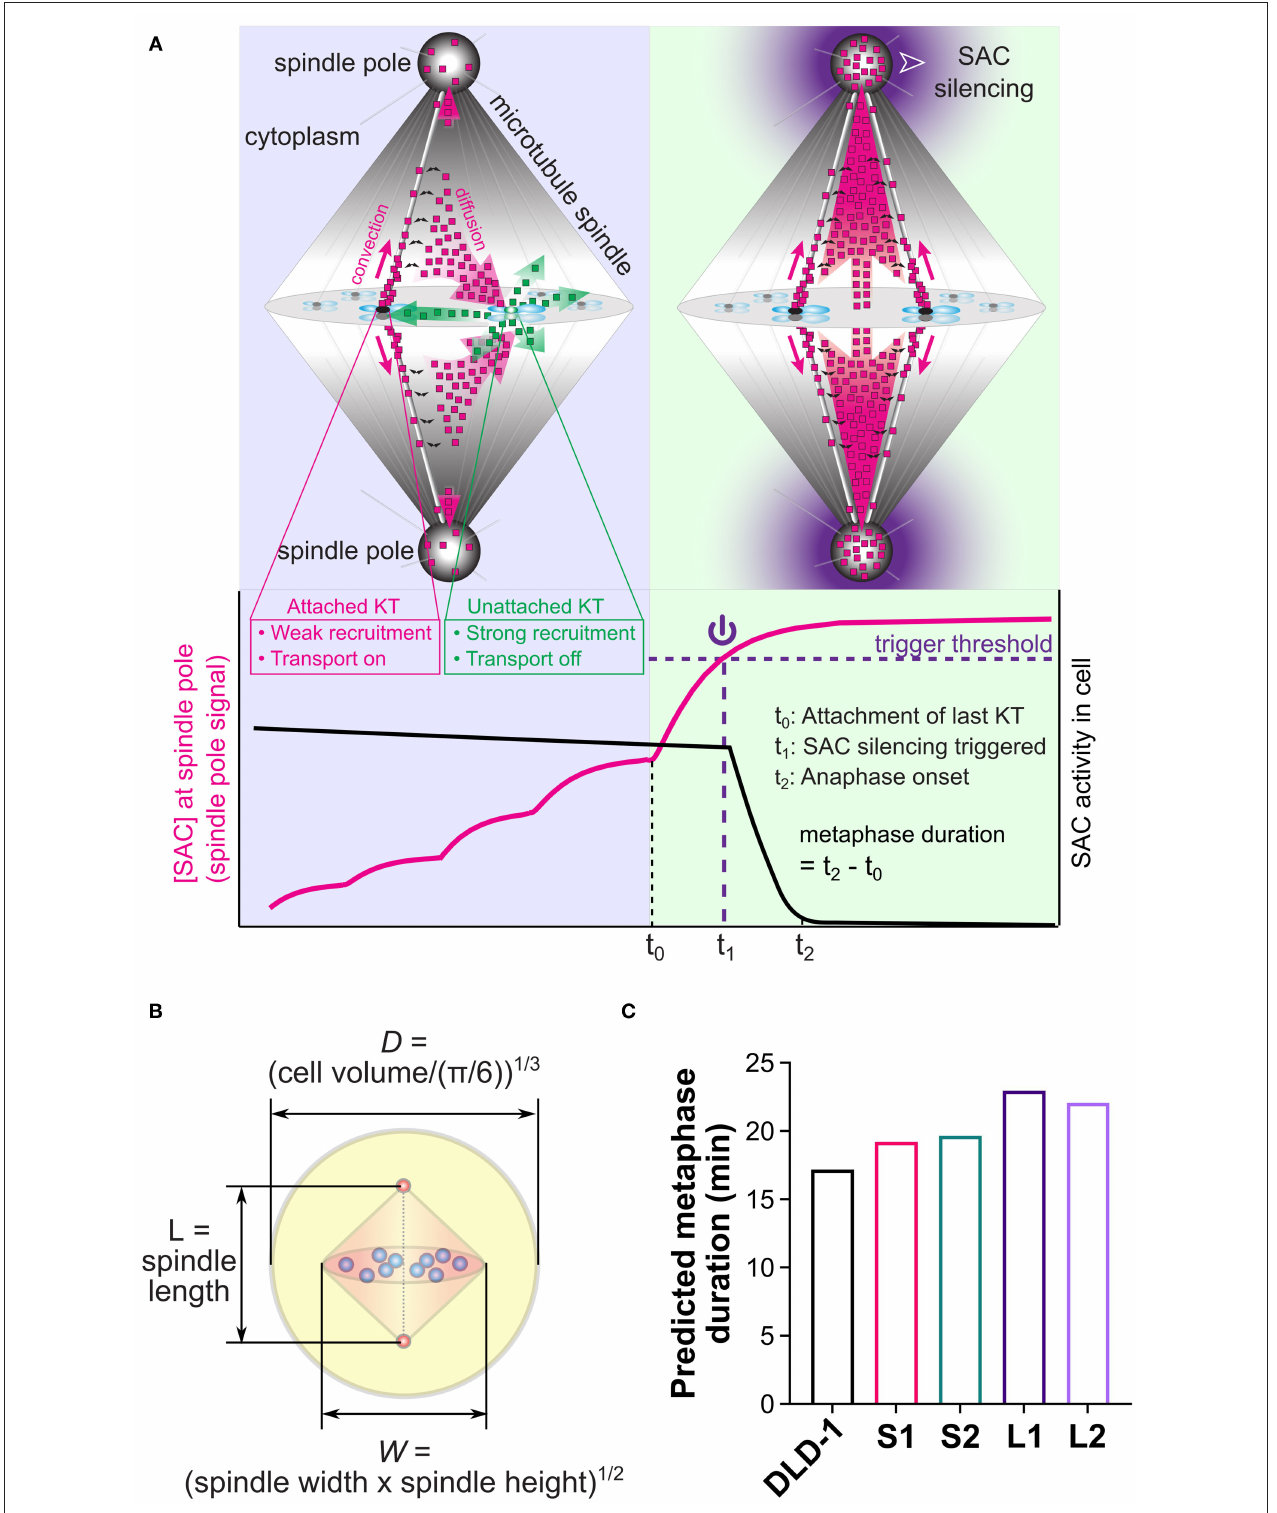
FIGURE 5 | Mathematical model for spatiotemporal regulation of SAC silencing. (A) Cartoon summary of the model. Upper panels illustrate the key model assumptions: (a) High phosphorylation level at unattached kinetochores (e.g., right kinetochore in the upper left panel) promotes recruitment of SAC proteins and